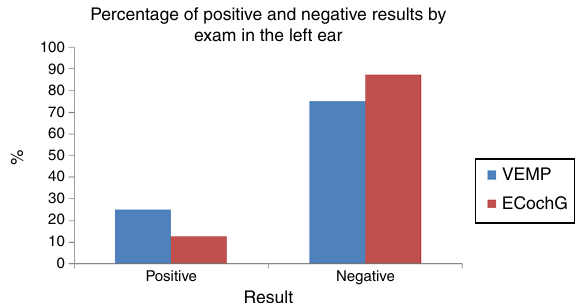
Figure 6 Percentage of positive and negative results by exam in the left ear. (25.0---75.0%) did not differ significantly in the proportion of positive and negative results in EcochG (12.5---87.5%; p = 0.2568; Fig.